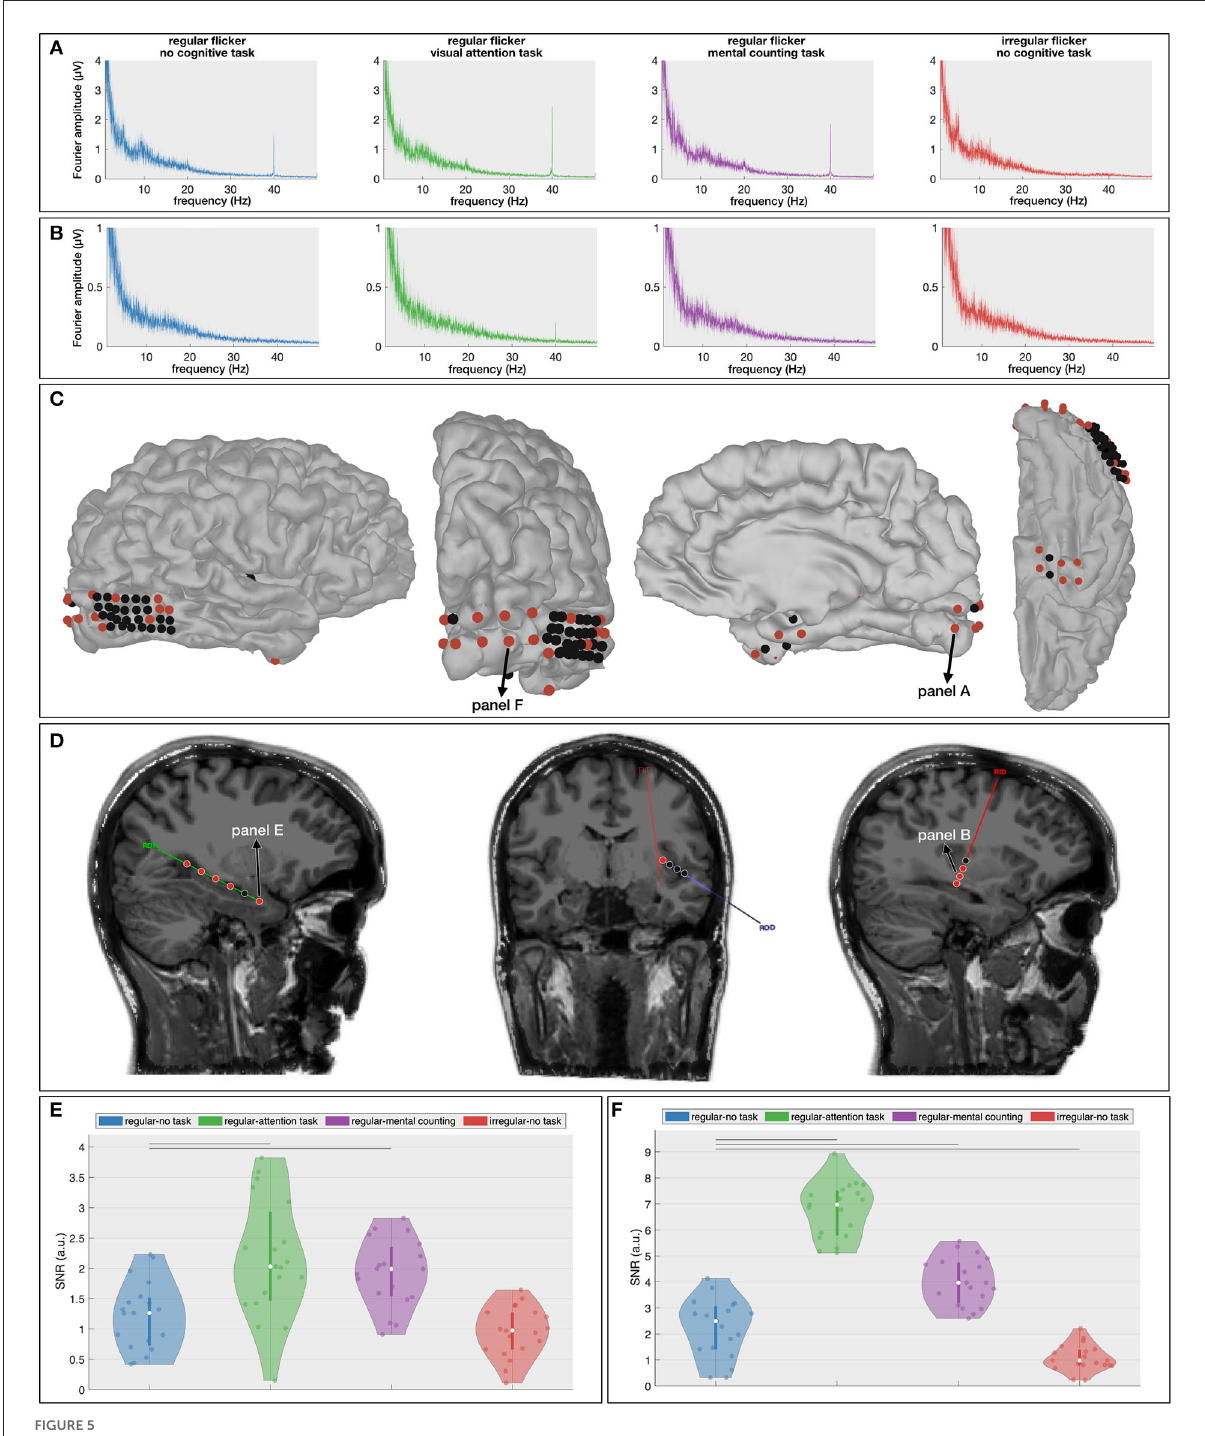
FIGURE5 Intracranial results. (A,B) Frequency spectra for the four presented conditions at one cortical [ (A) , primary visual cortex] and one depth [ (B) , insular cortex] contact. These spectra show the increased gamma entrainment when the subject is instructed to perform a cognitive task during the visual stimulation. (C,D) Localization of the cortical (C) and depth (D) contacts. Electrodes that exhibit a significant difference in gamma entrainment across the four conditions using Kruskall-Wallis test are indicated in red. (D,E) Signal-to-noise ratio (SNR) boxplots in response to the four stimulation conditions for one hippocampal contact (E) and one occipital electrode (F) . Note that their locations are marked in (C,D) . The horizontal lines above the boxplots indicate the pairs that exhibit a statistically significant difference with no-task condition (Wilcoxon rank-sum test with FDR